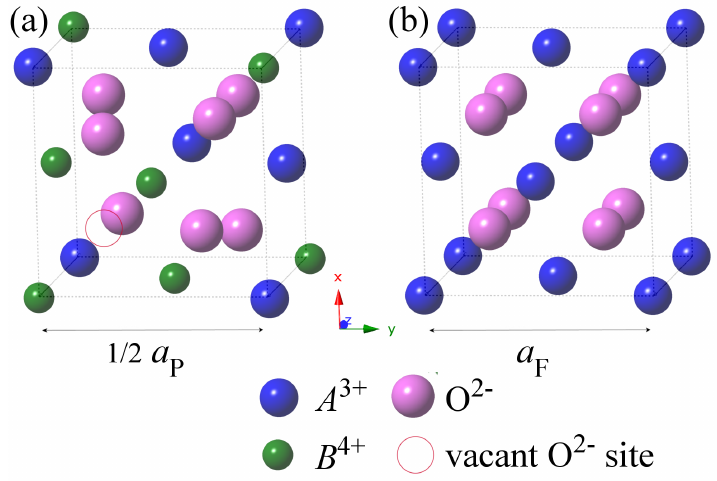
Figure 2. ( a ) The pyrochlore crystal structure is shown as a derivative of the fluorite structure; ( b ) For comparison, the unit cell of the fluorite lattice is depicted.